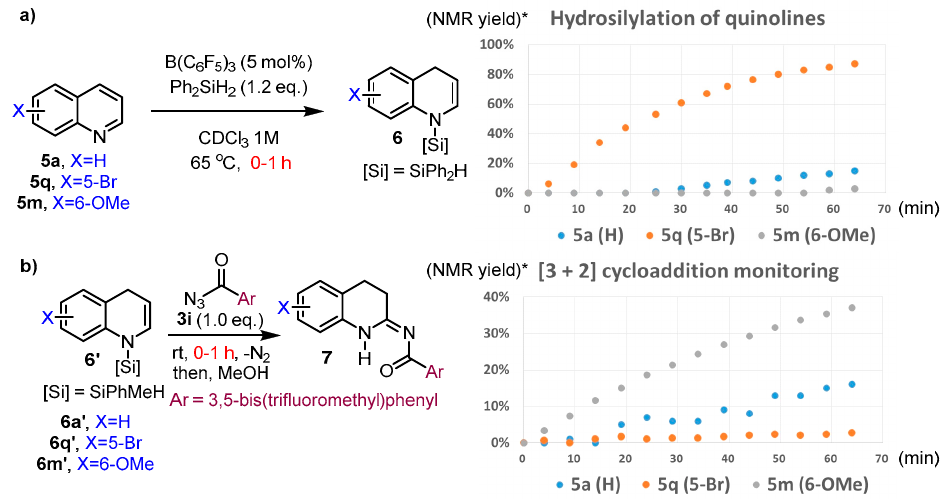
the electron density of N -silyl enamine 6 (cid:48) and the reaction rate of the cycloaddition